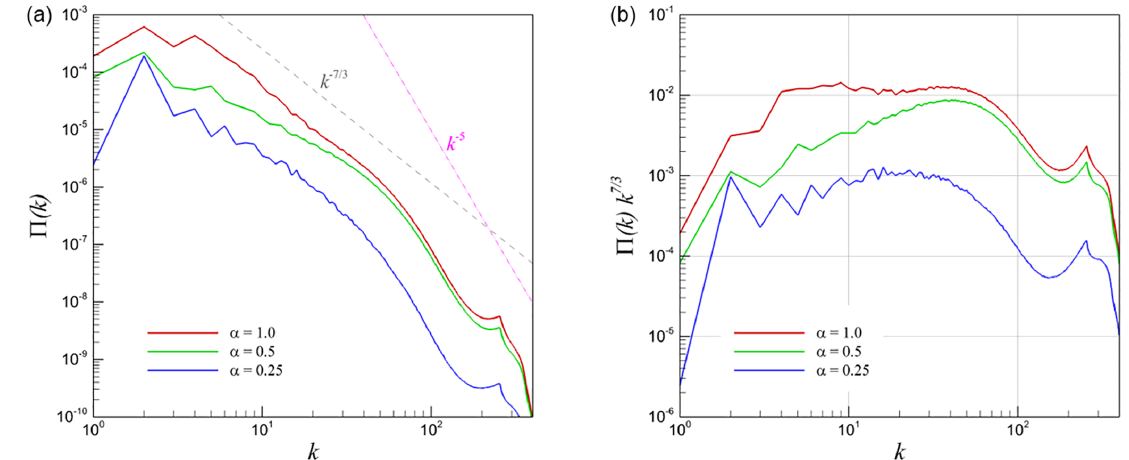
Figure 19. Spherical-averaged pressure power spectra for 3-D KHI turbulence (a) and its compensated form (b) .